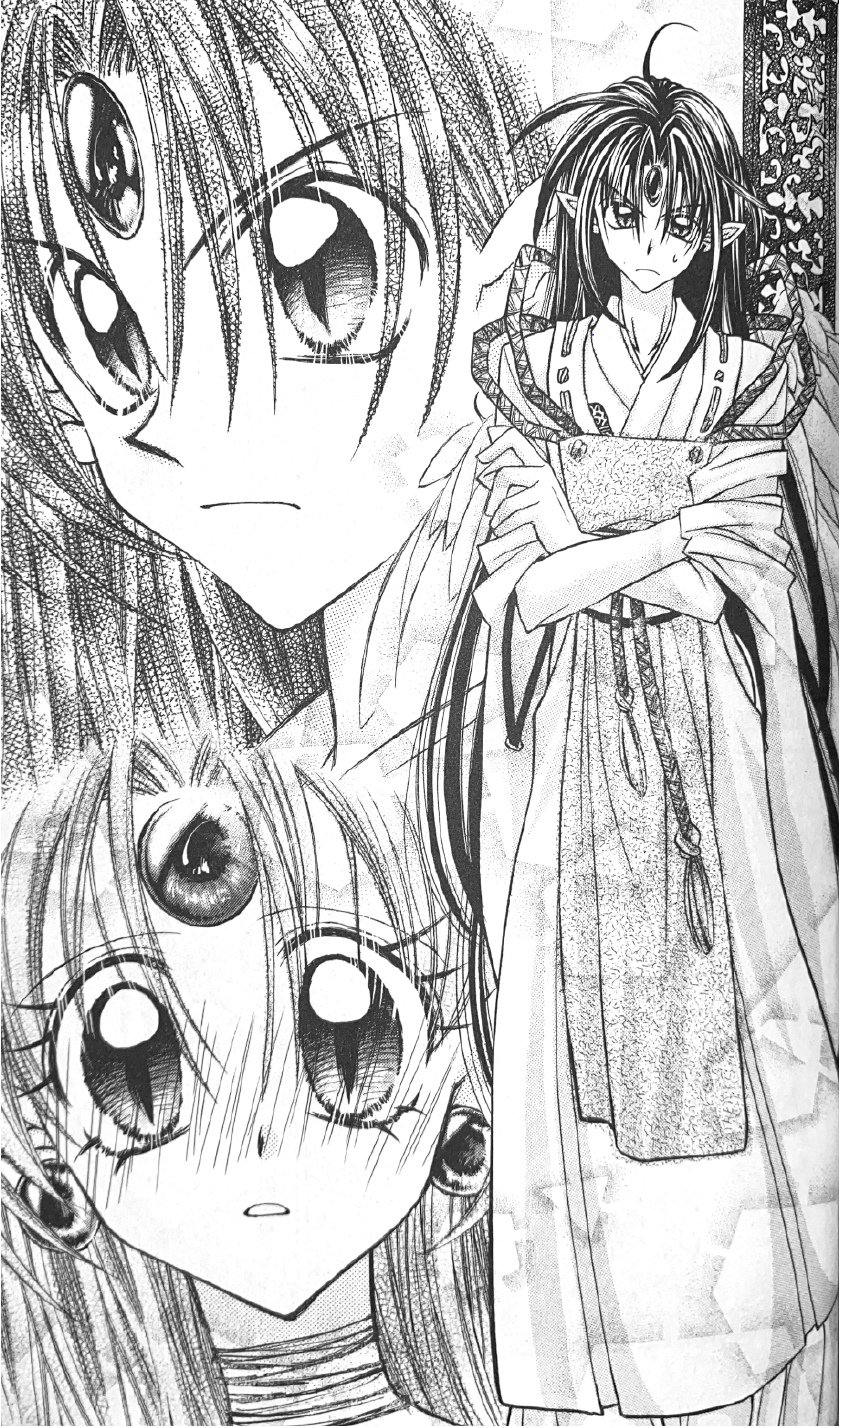
Figure 9 Image of pure angel Access Time after God helped him to become a pure angel, pictured alongside Fin Fish as fallen angel (Tanemura